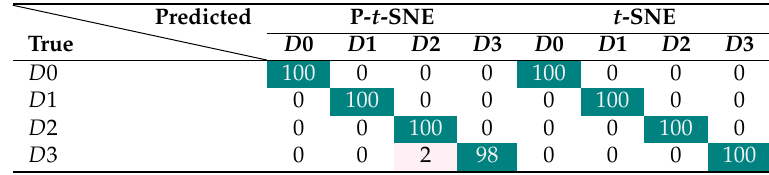
Table 2. Confusion matrix of the application of P- t -SNE and t -SNE damage detection and classification method presented in Sections 3 and 4: scenario 1 and the sum of the inverse distances approach. Predicted P- t -SNE True 0